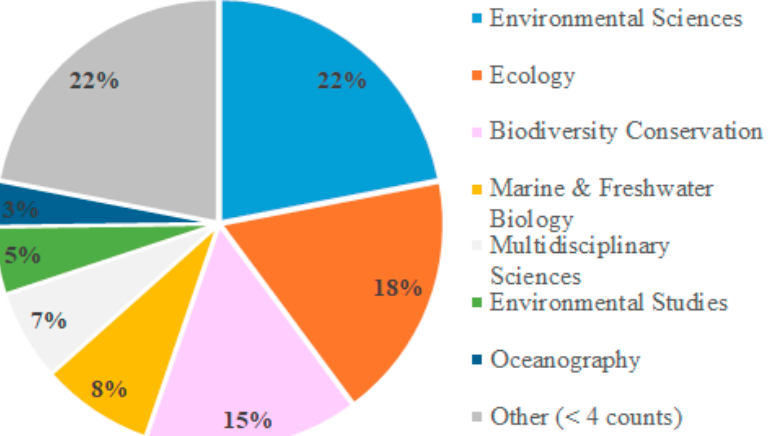
Figure 6. Subject categories of journals publishing the articles from the systematic literature review.